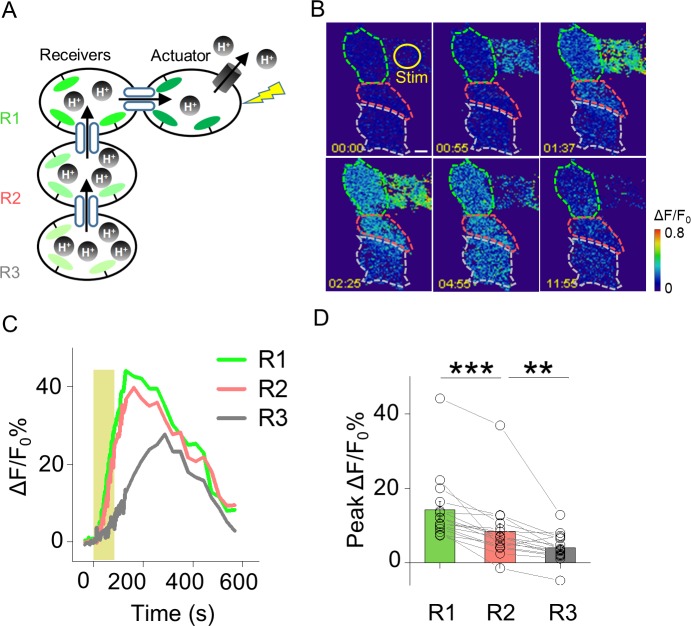
Probing GJC propagation within connected HEK293T cells by PARIS.(A) Schematic diagram depicting a cluster of four HEK293T cells connected by gap junctions. One cell expresses the actuator, and the three receiver cells (R1, R2, and R3) are connected in series to the actuator. (B,C) Time-lapse pseudocolor images and ΔF/F0 traces of the PARIS signals measured in the receiver cells following light-induced activation of the actuator cell. (D) Group data of the peak change in pHluorinCAAX fluorescence in cells R1, R2, and R3 measured as shown in (B); n = 16 cells per group. The scale bar in (B) represents 10 μm. **p<0.005 and ***p<0.001.